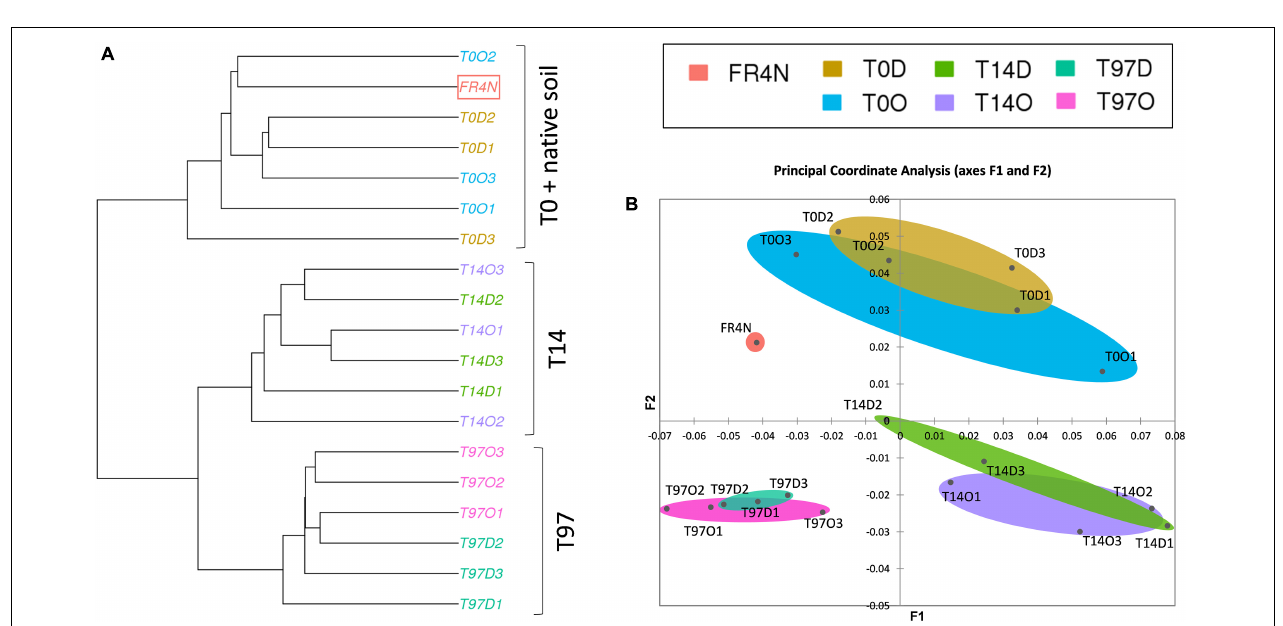
FIGURE 4 | (A) Ward D2 linkage clustering tree of the different samples based on the 16S OTUs repartition and beta diversity values (Bray–Curtis dissimilarities) and (B) principal coordinate analysis (PCoA) based on Bray–Curtis dissimilarity distances between the different samples.